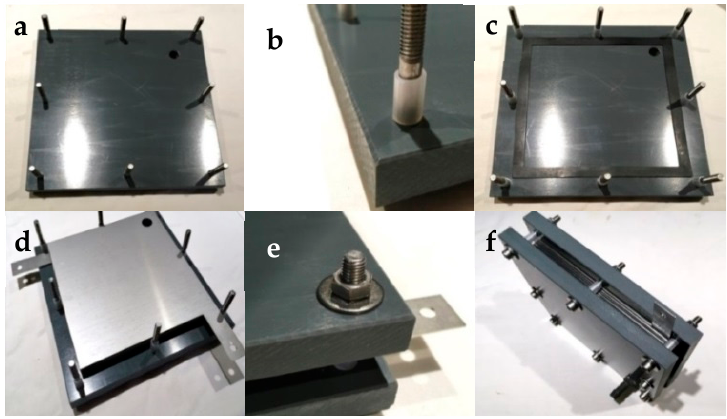
Figure A1. Dry cell assembly.